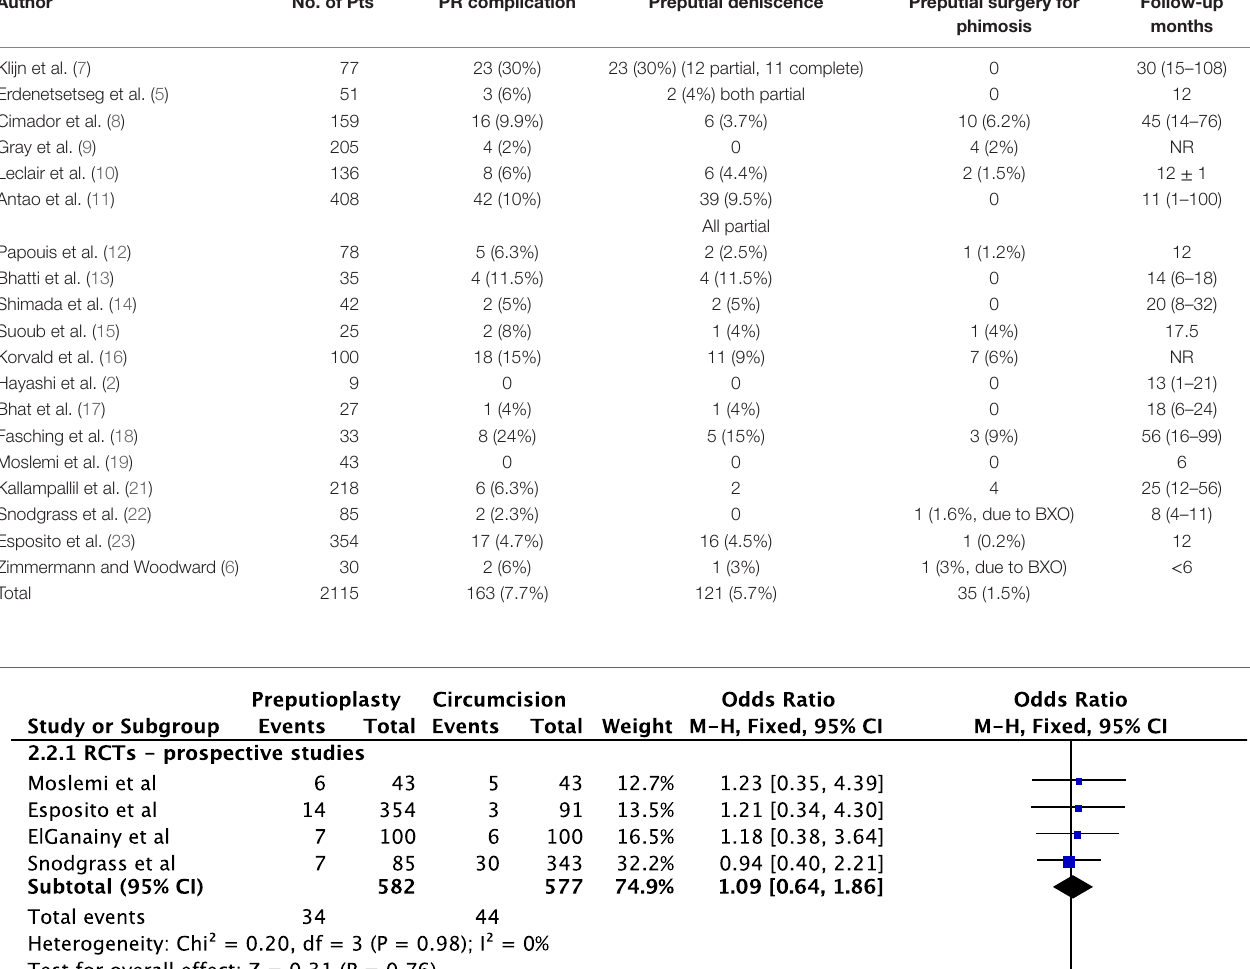
TaBle 2 | complications of preputial reconstruction